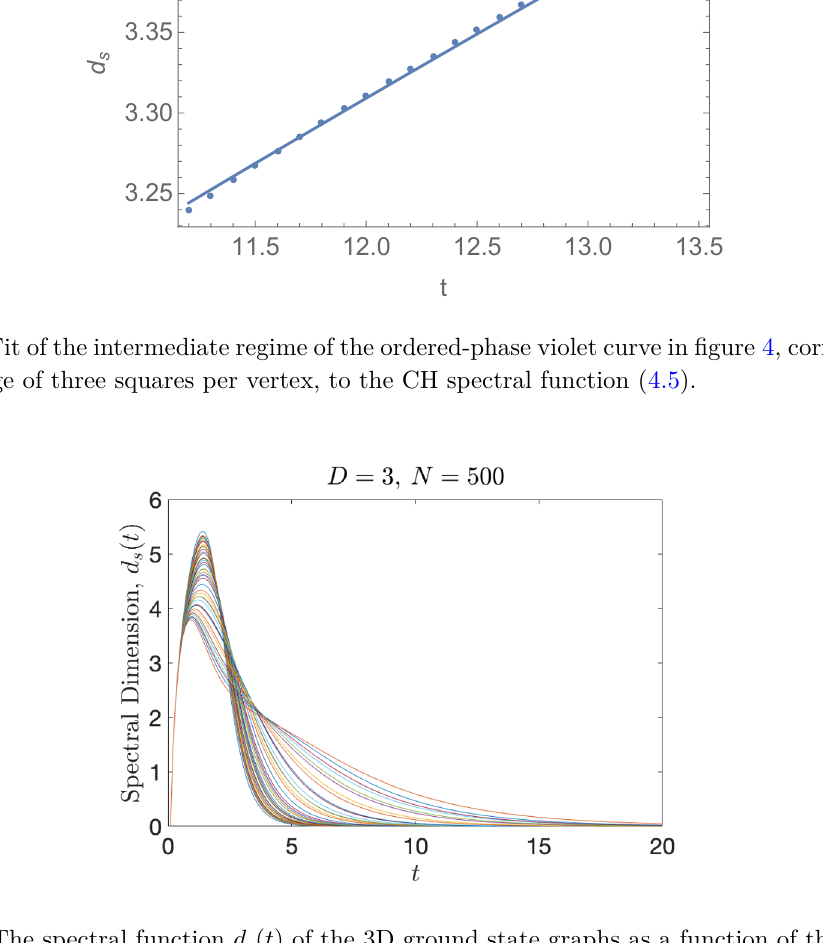
Figure 7 . The spectral function d s ( t ) of the 3D ground state graphs as a function of the coupling constant g ~ . The phase transition is evident also here but graphs that can be treated with present computational power are way to small to identify the continuum regime in